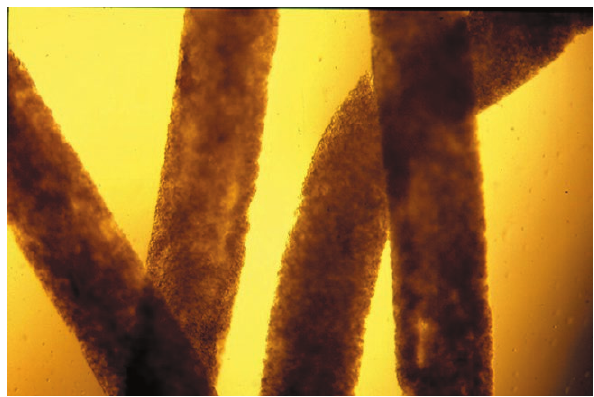
Figure 5. Photomicrograph of gel-threads showing cancer cells embedded in perfusable gel. 41